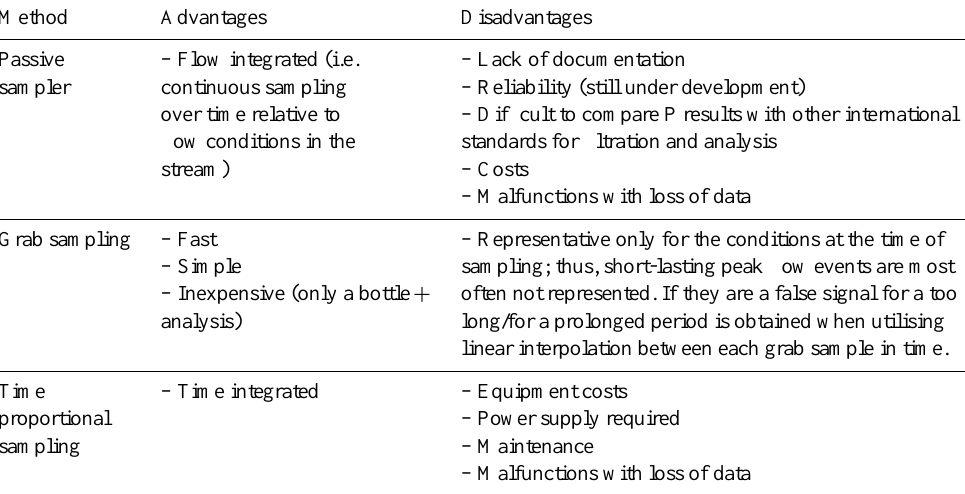
Table 4. Advantages and disadvantages of the three nutrient monitoring methods tested in the present